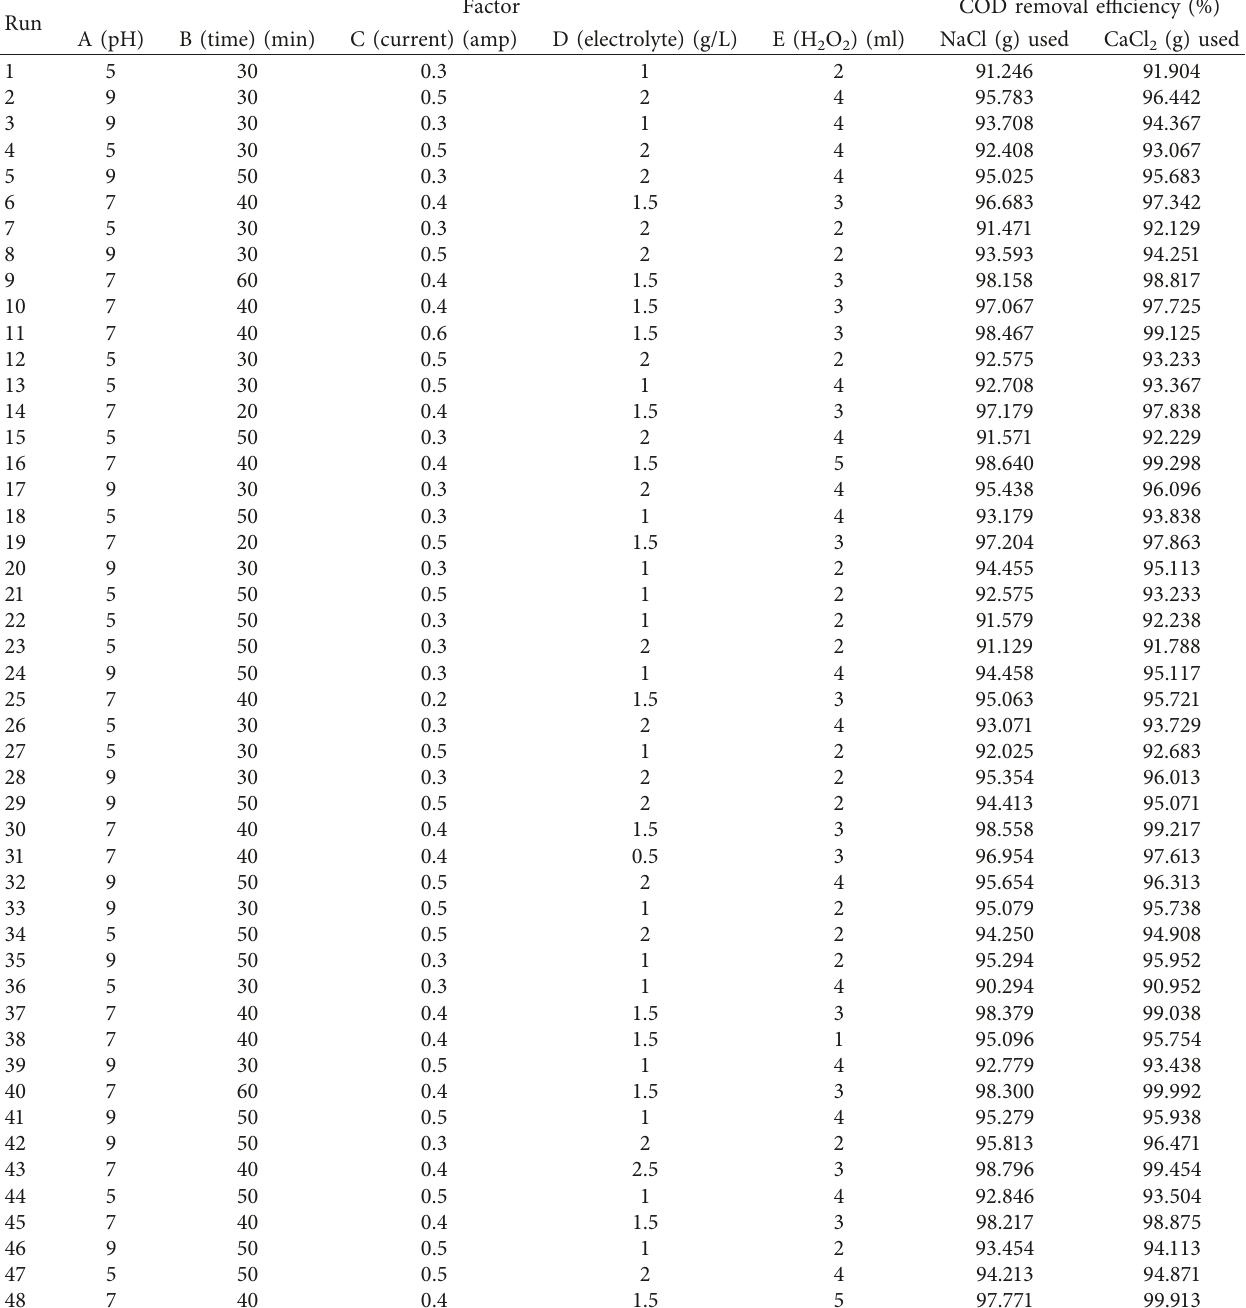
Table 2: FCCD for COD removal by ECO/NaCl and ECO/CaCl 2 with UV/H 2 O 2 . Factor COD removal efficiency Run